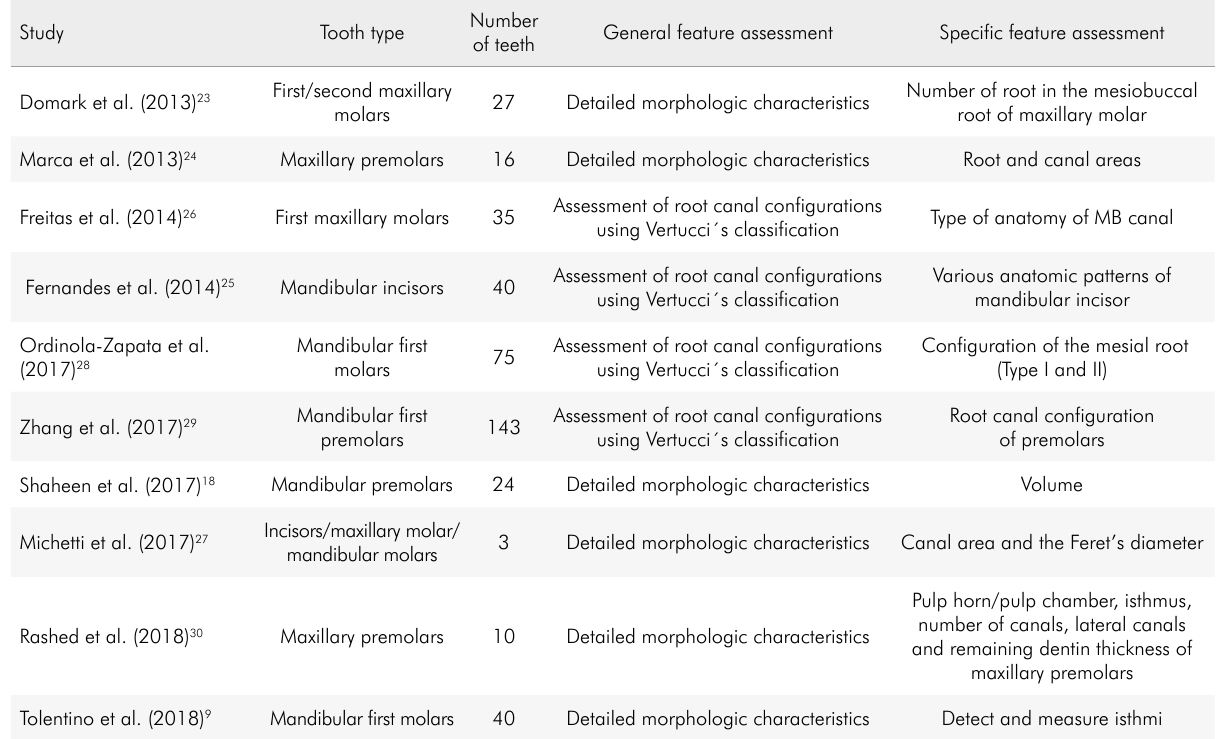
Table 1. Main characteristics of the included studies: sample